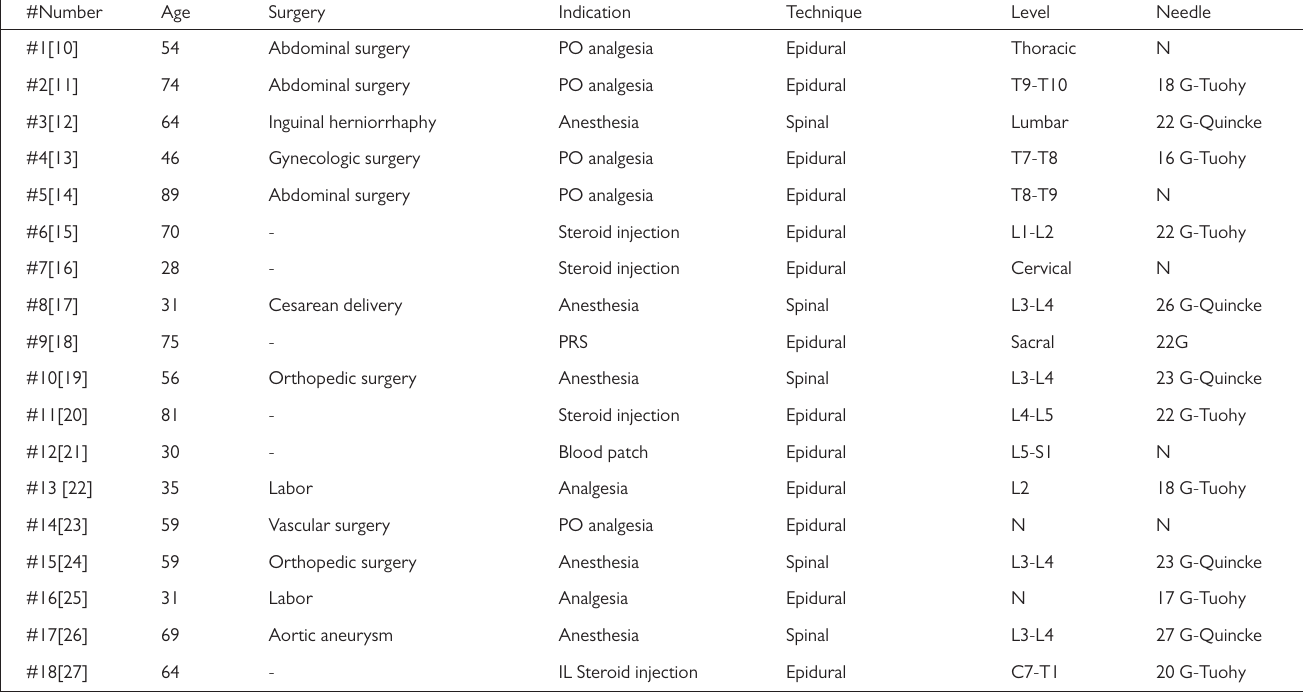
Table 1. Locoregional technique setting